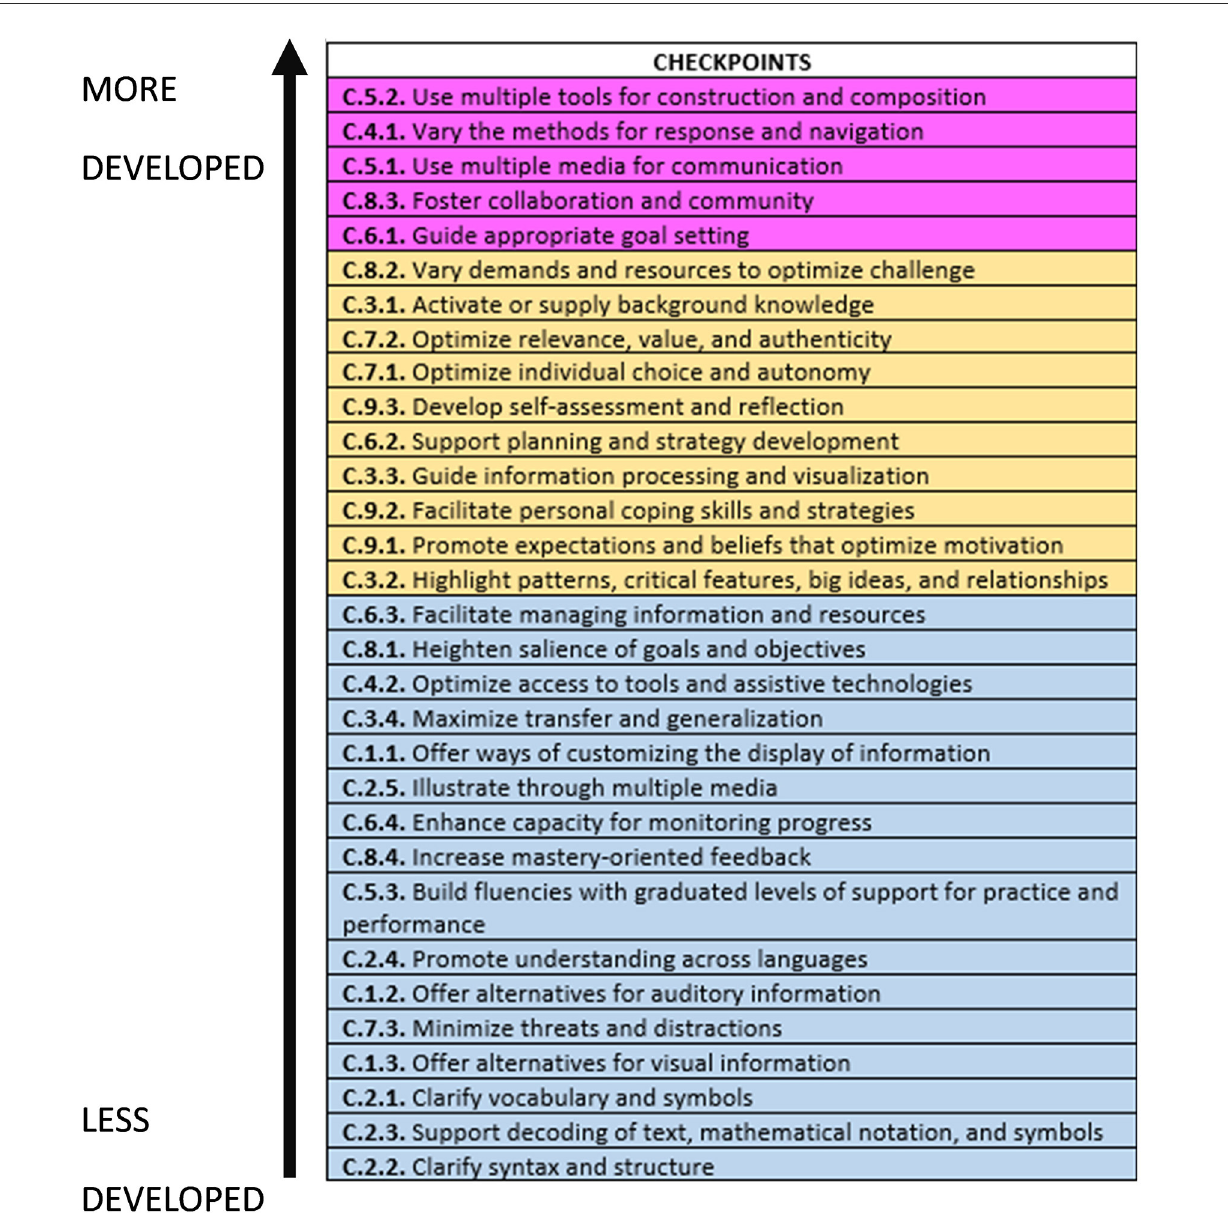
FIGURE7 Checkpoints ranked according to their use from the highest to the lowest, and according to whether they are close to transmedia storytelling ideas (magenta), UD-L foundational research ideas (yellow), and accessibility